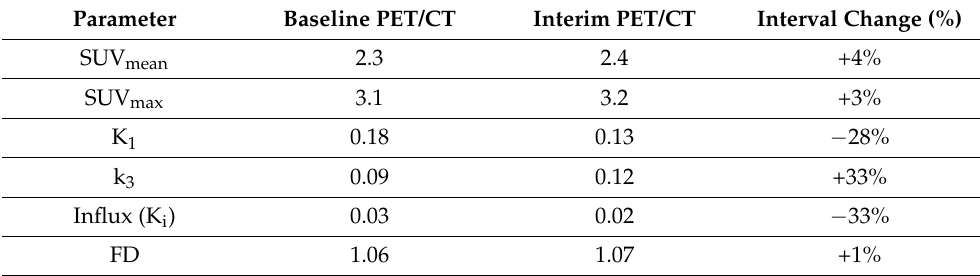
Table 5. Median values of the 18 F-FDG semiquantitative and quantitative parameters, derived from the bone marrow, before and after two cycles of anti-PD-1 therapy as well as their interval changes (%) as a response to treatment. The units of parameters K 1 , k 3 and influx are 1/min. SUV mean , SUV max and FD have no unit.